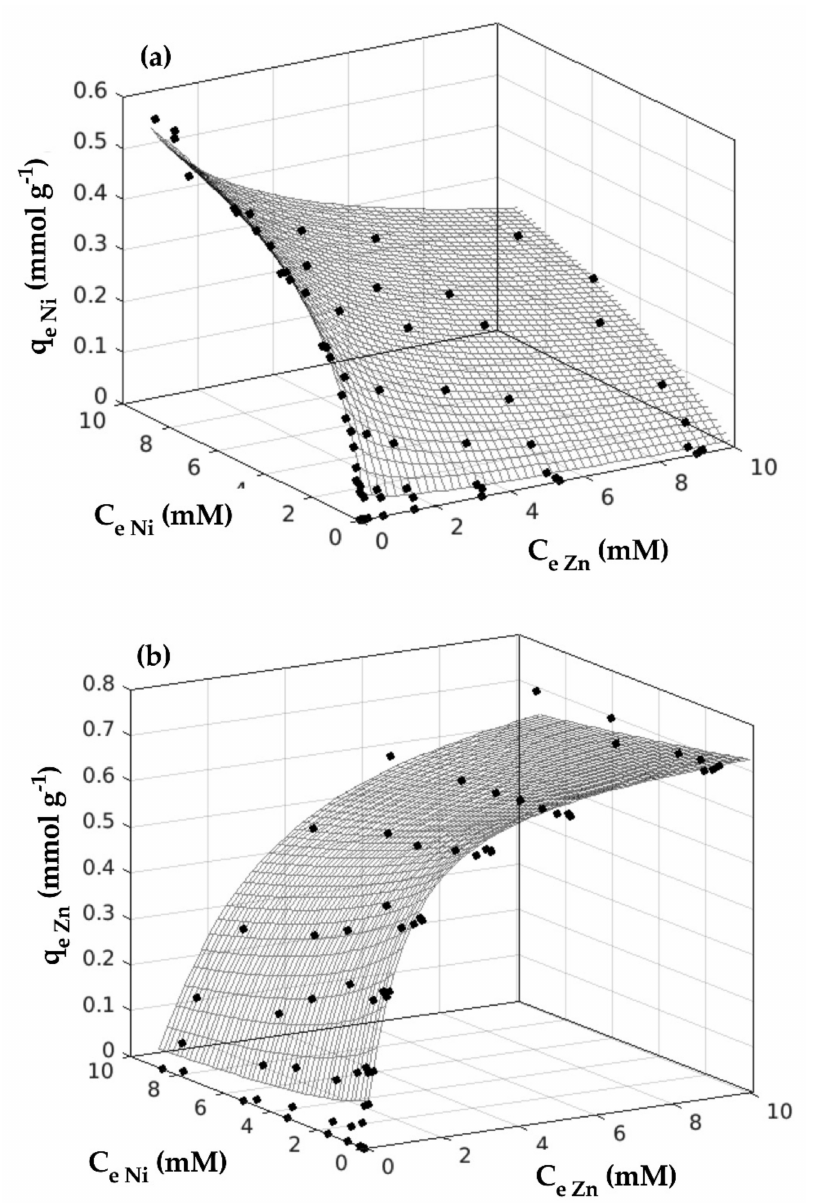
Figure 5. Isotherms of Ni 2 + ( a ) and Zn 2 + ( b ) biosorption on Lemna gibba in binary metal systems ( • experimental data; — (mesh surface), modified Sips model